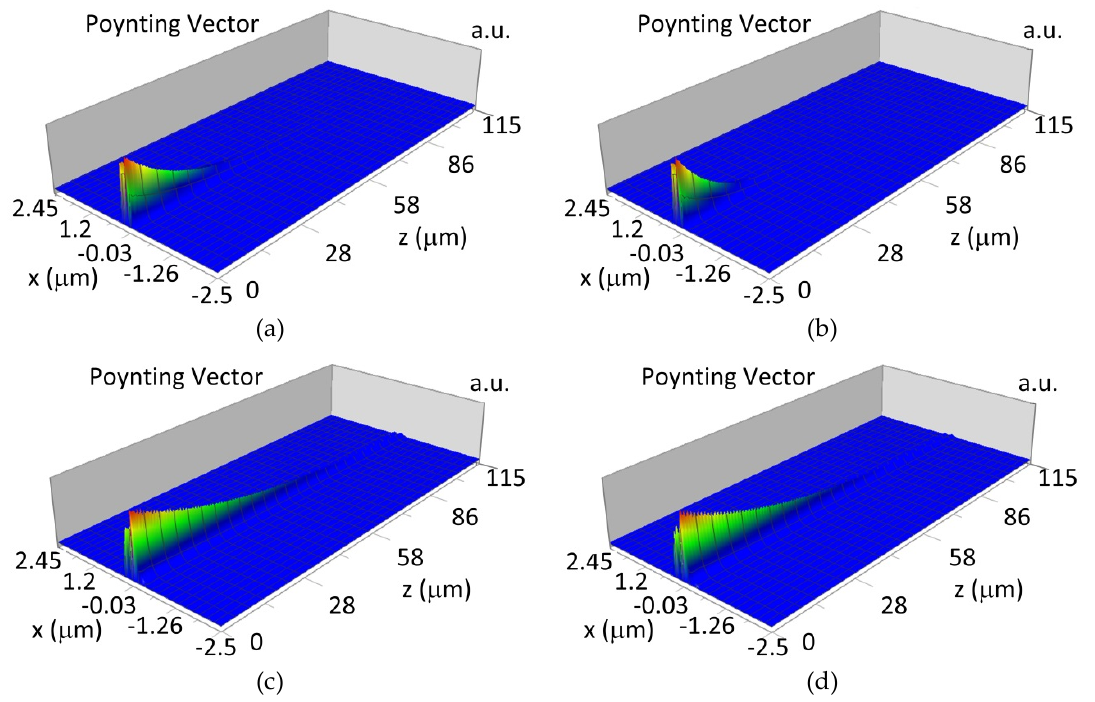
Figure 16. Propagation light in waveguide structure for TM01, d w = 237 nm (Poynting vector): ( a ) λ = 436 nm, Hb O2 , ( b ) λ = 436 nm, Hb, ( c ) λ = 560 nm, Hb O2 , ( d ) λ = 560 nm, Hb.